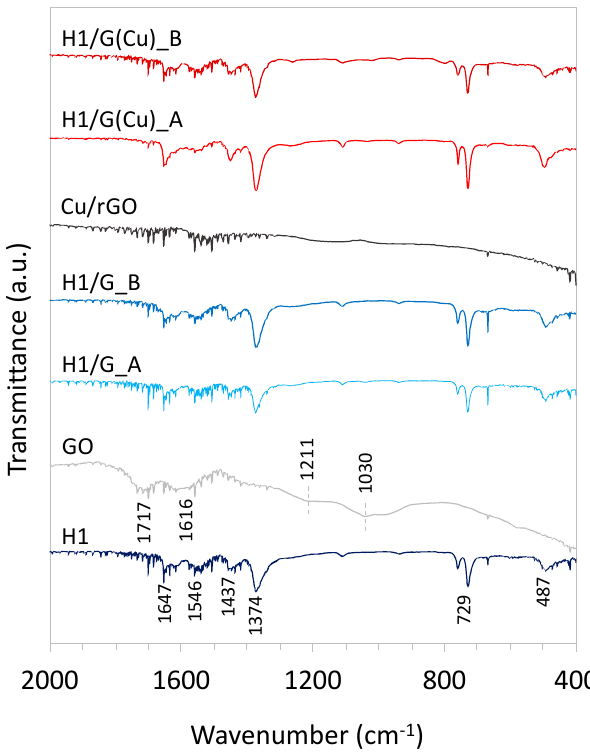
Figure 5. FTIR spectra of HKUST-1/GO composites and their components collected in 2000–400 cm − 1 range.